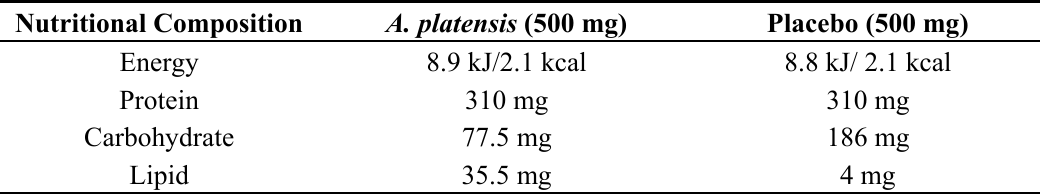
Table 1. Nutritional composition of the intervention and placebo products. Nutritional